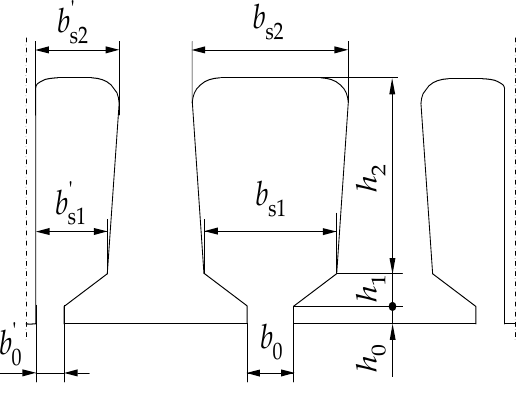
Figure 7. The shape of the stator slots.